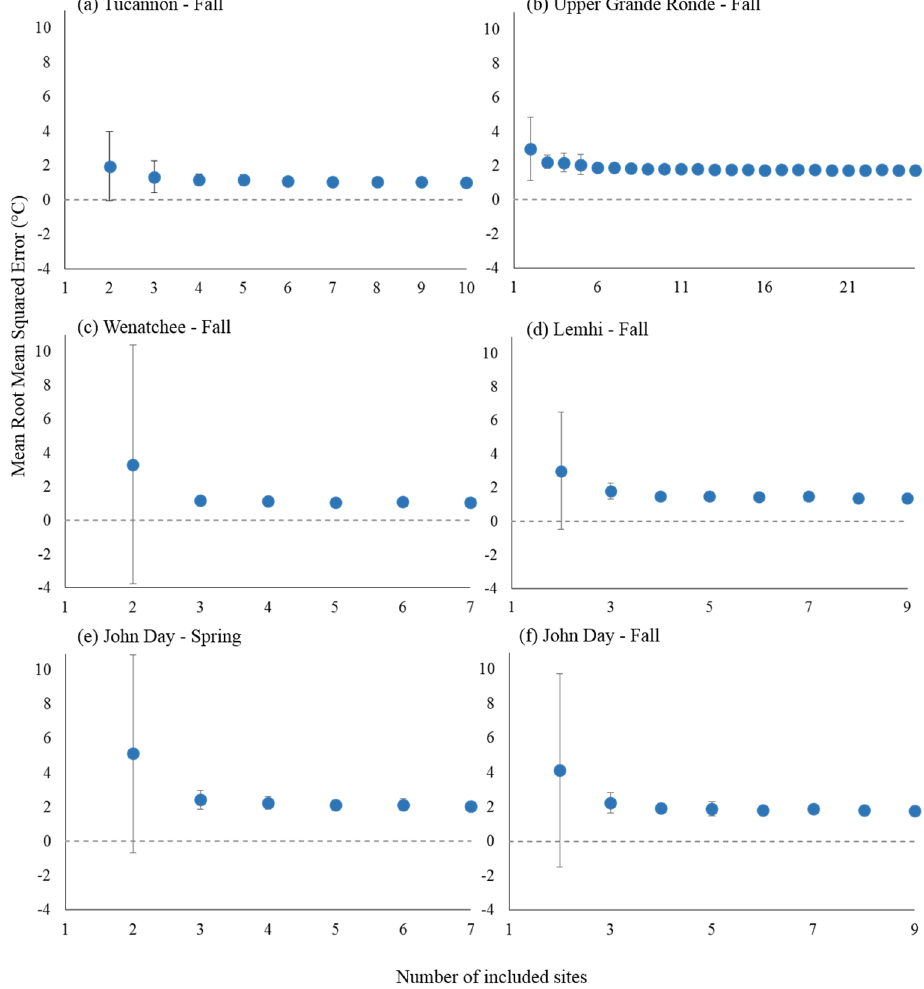
Figure 10. Sensitivity analysis mean root mean squared errors (and standard deviation of those means) from the N-i site jackknife for all basins. Mean Root Mean Squared Errors on the Y-axis, and the number of included sites on the X-axis for all graphs. “Spring” indicates data from the first half of the year (and “Fall” the second half) as determined by the peak mean temperature across the year.